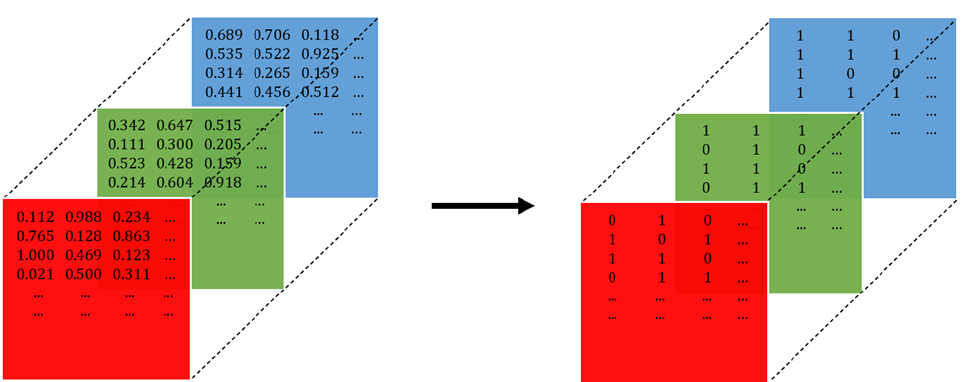
Figure 5. We considered each R, G, and B colour array of an image to be a fuzzy set ( left ). We then reduced each set to an α -cut ( right ) according to a value α . In this example, α = 0.3. The newly created α A sets were populated according to this: any element of each fuzzy set that was greater than or equal to 0.3 was also an element of the crisp set 0.3 A and therefore took a value of 1, with the rest taking a value of